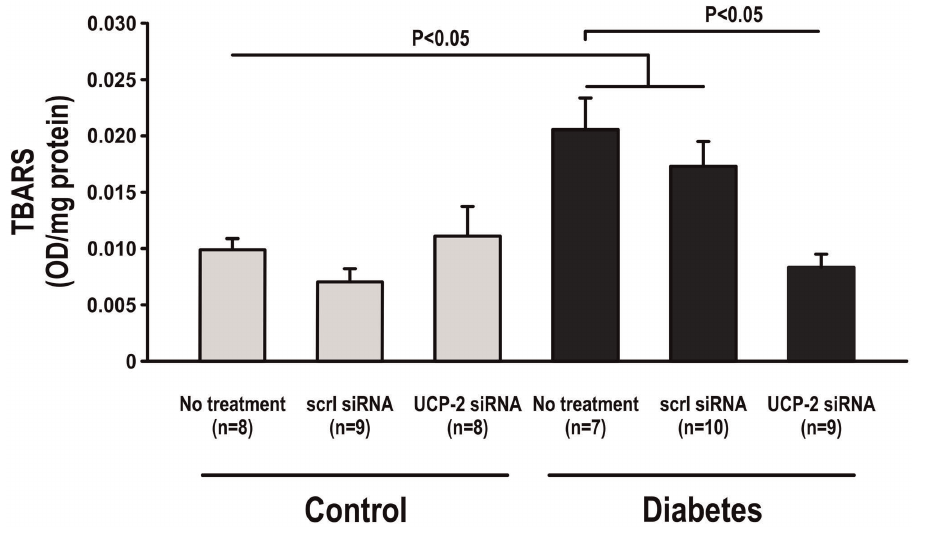
Figure 9. Kidney tissue oxidative stress levels measured as TBARS in control and diabetic animals with and without scrambled or UCP-2 siRNA.